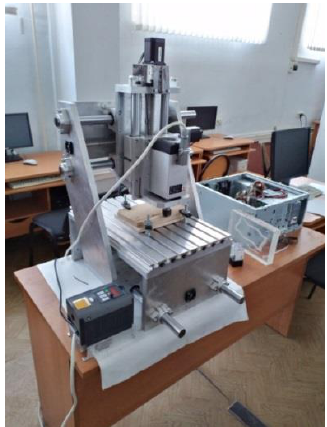
Fig. 2. Three-axis CNC milling machine, the result of design